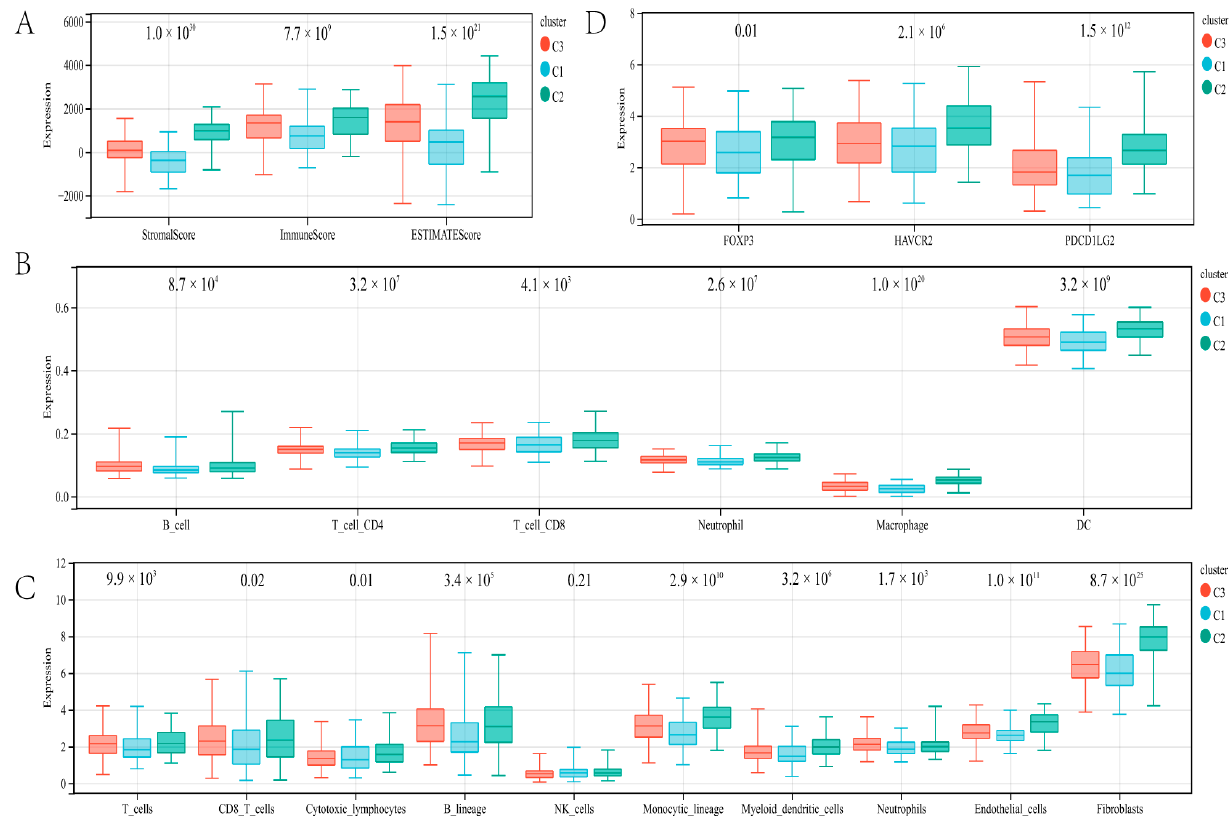
Figure 3. Immune landscape analysis: The immune microenvironment was evaluated by the ESTI- MATE algorithm ( A ), TIMER algorithm ( B ), and MCPcounter algorithms ( C ). ( D ) Expression analysis of immune checkpoints.